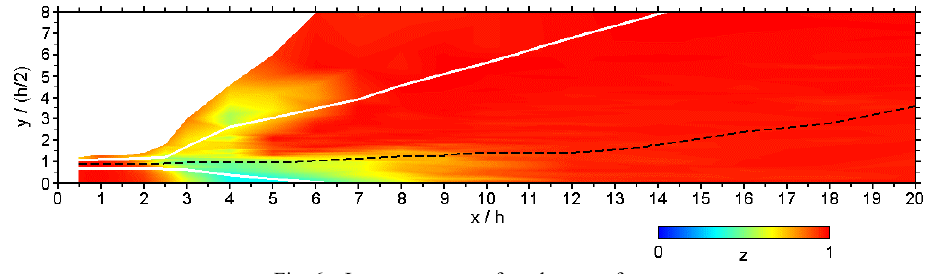
Fig. 6 Isocontour map of randomness